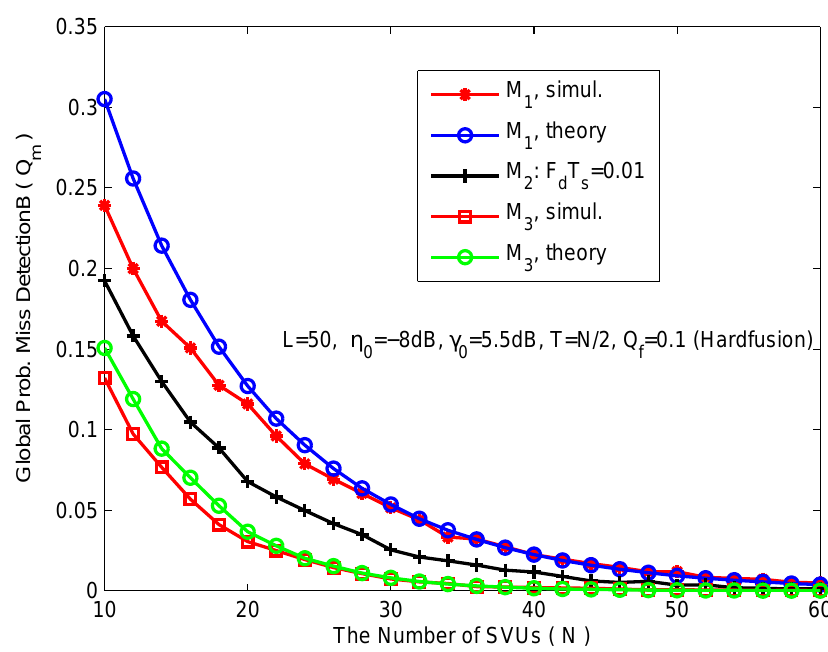
Figure 6. The global probability of misdetection as a function of the number of SVUs.